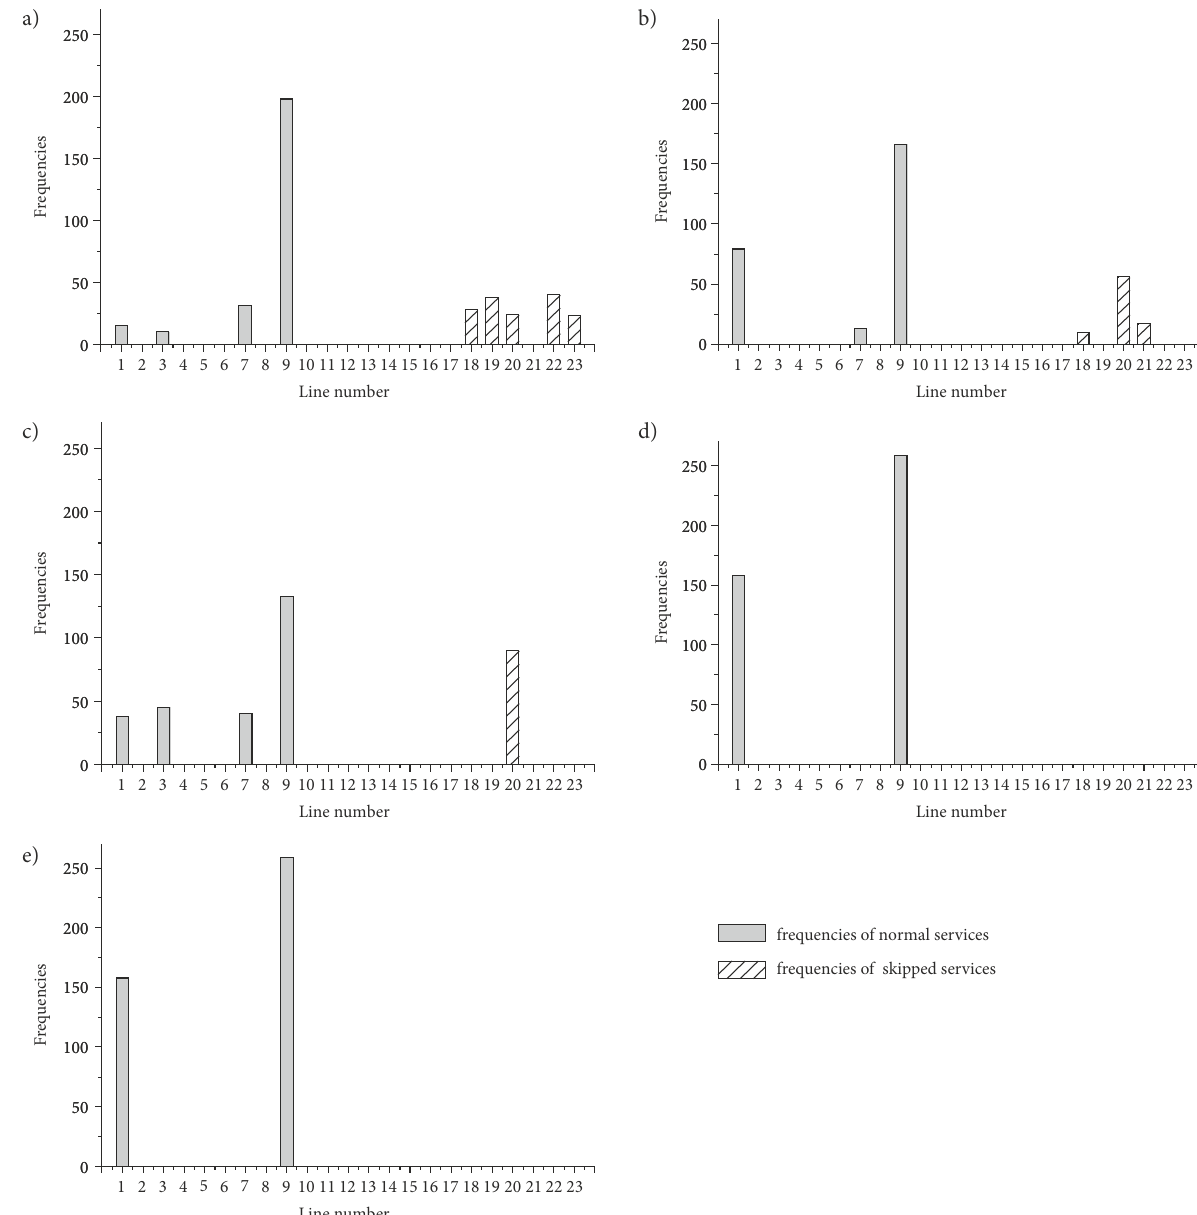
Figure 12. Optimal line frequencies for different values of θ l : a – θ l = 0.1; b – θ l = 0.2; c – θ l = 0.3; d – θ l = 0.4; e – θ l =